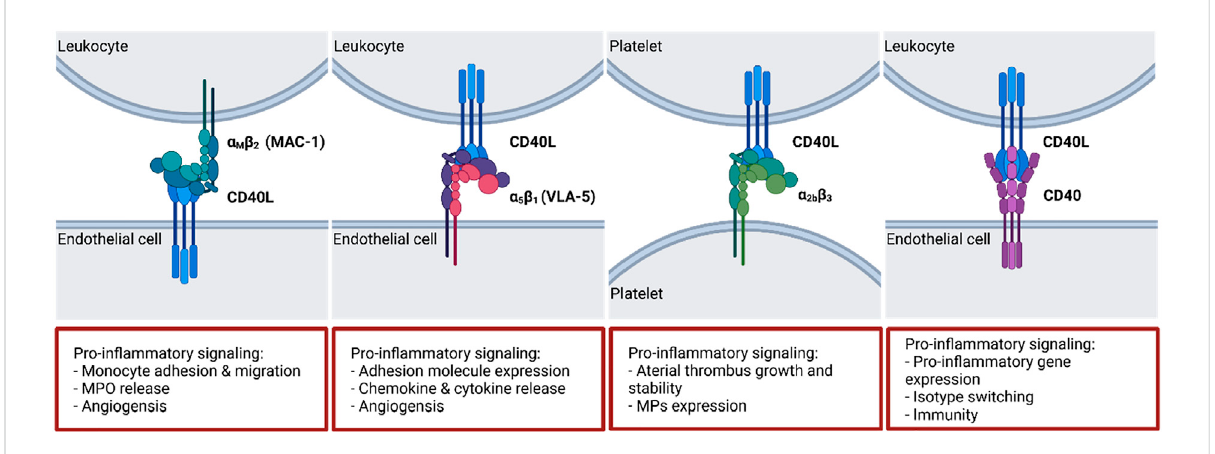
FIGURE 3 CD40(L) and its ligands and receptors. While CD40L has multiple binding partners, CD40 is largely restricted to ligation by CD40L. The dyad regulates multiple crucial biological processes including isotype switching, thrombus stabilization and cell activation. A selection of typical effects elicited by the interactions is presented on the bottom. A M β 2 : Macrophage antigen 1 (MAC-1); α 5 β 1 : Fibronectin receptor (also: Very late antigen 5 (VLA-5));